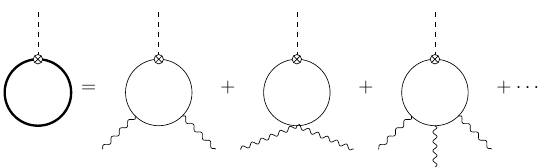
Figure 1 . The schematic picture that the propagator induces the scalar field couplings to the curvature tensors. The thick line on the left hand side indicates the full propagator of the heavy intermediate particle, which contains the curvature tensors as indicated on the right hand side. The vertex insertion is indicated by the crossed dot, the scalar field by the dashed lines, and the graviton by the wavy